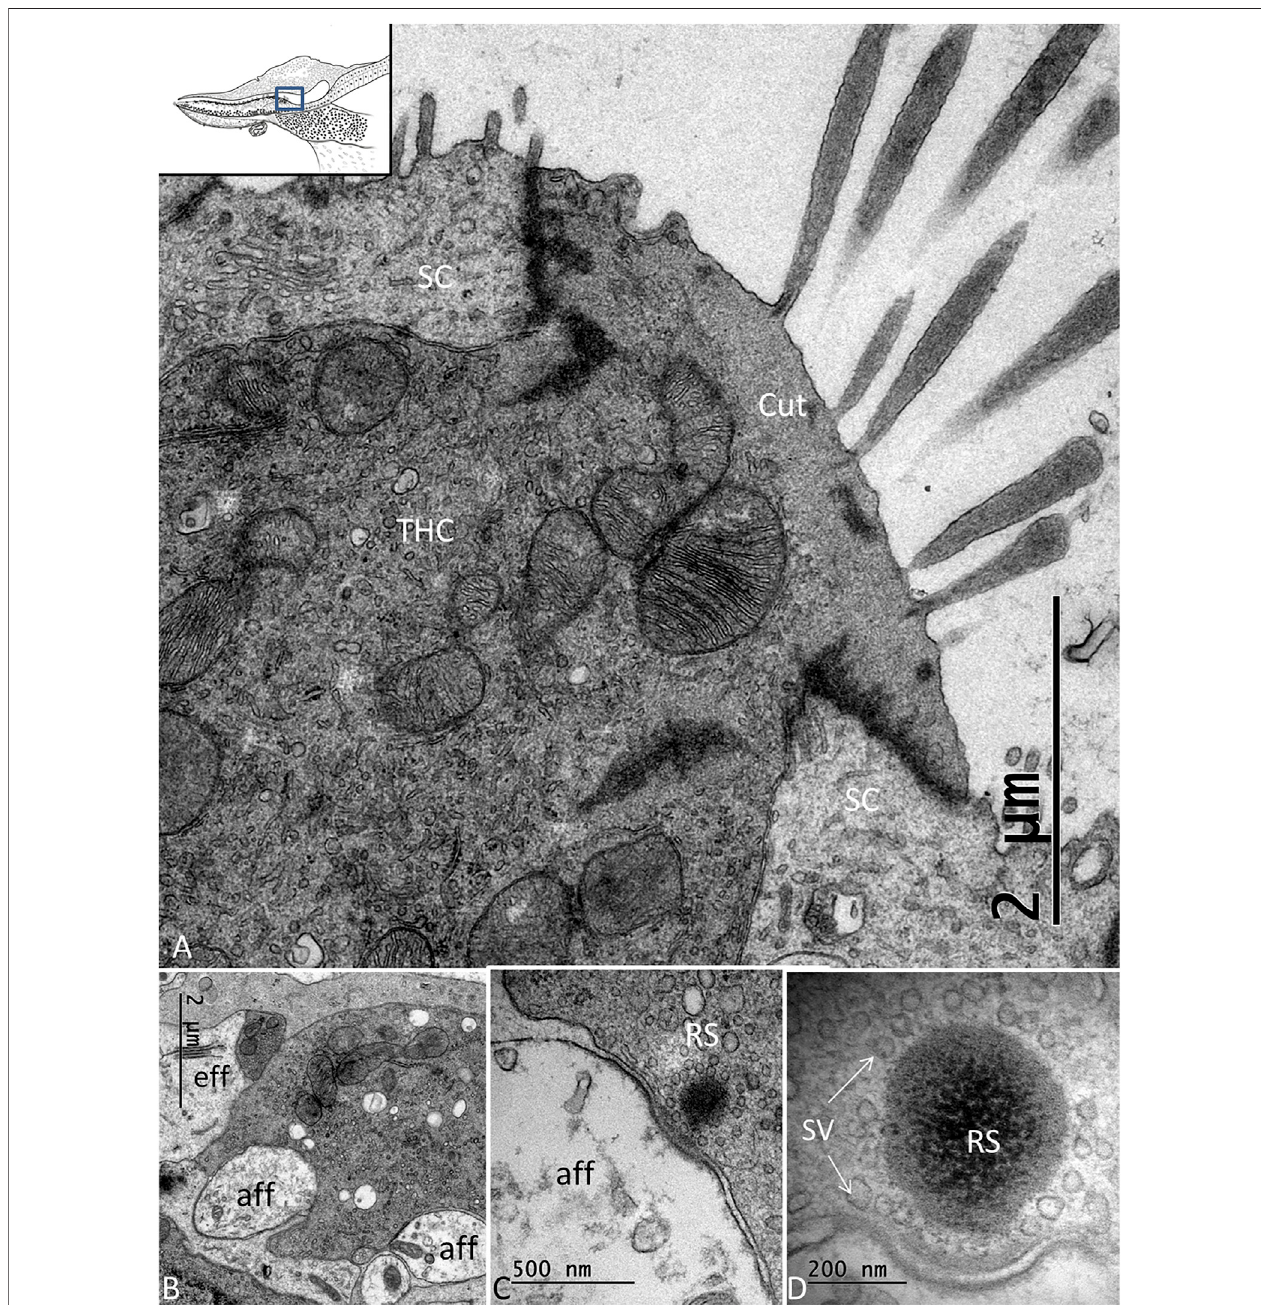
FIGURE 4 | (A) . TEM of a THC in the C. rhombifer . It is surrounded by two SCs. Stereocilia are anchored in the cuticula (Cut). (B) . Several afferents and an efferent terminalinnervatethehaircells. (C) .AnRSissurroundedbyahaloofclearsynapticvesicles(SVs).Adensepostsynapticmembraneisseen. (D) .Highermagni fi cationof an RS with a large dense body surrounded by